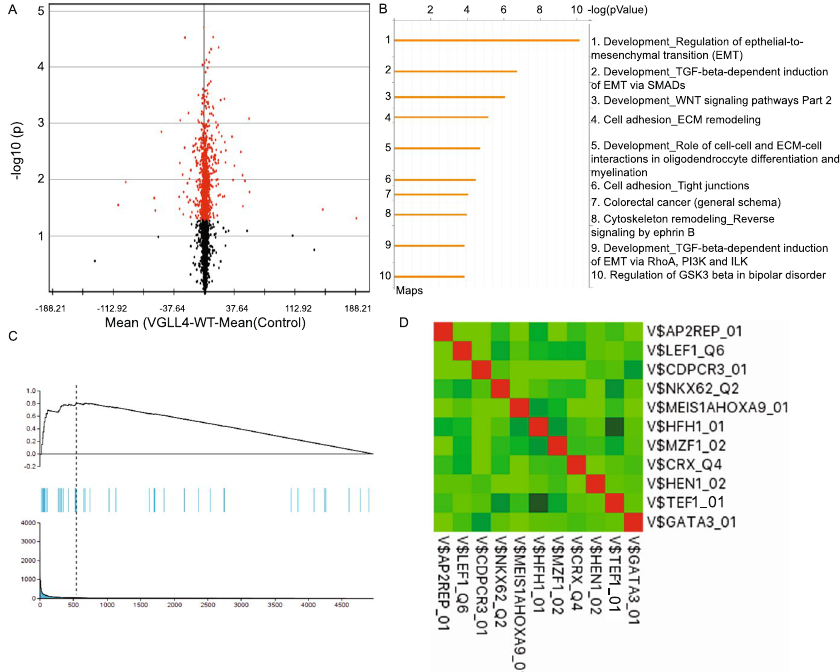
Figure 4. VGLL4-regulated gene expression. ( A ) Volcano plot displaying the − log10 of the P values from modified T-test in terms of the log2 fold change for VGLL4 overexpressing cells. The selected genes have significantly different expression values (P ≤ 10 − 15–P ≤ 10 − 3). ( B ) GeneGo MetaCore data analysis of VGLL4- induced genes. Columns correspond to canonical pathways names − log(p value), percentage of genes detected in this pathway and molecules in this pathway. The top 10 pathways are summarized, additional information provided in Supplemental Table 2. ( C ) GSEA result analysis to assess enrichment of the YAP gene expression signature. NES, normalized enrichment score; FDR q-val, false discovery rate q-value (the probability that a gene set with a given NES represents a false-positive finding). ( D ) The cross-correlation coefficients